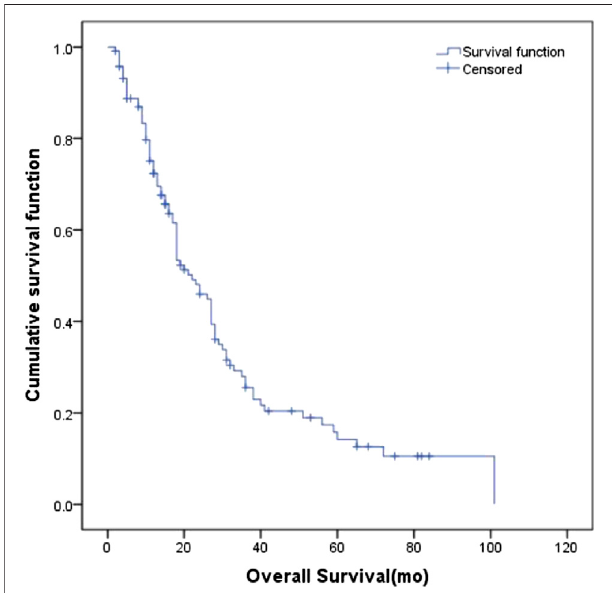
FIGURE 1 | The overall survival curve of the 118 patients with SCLC.